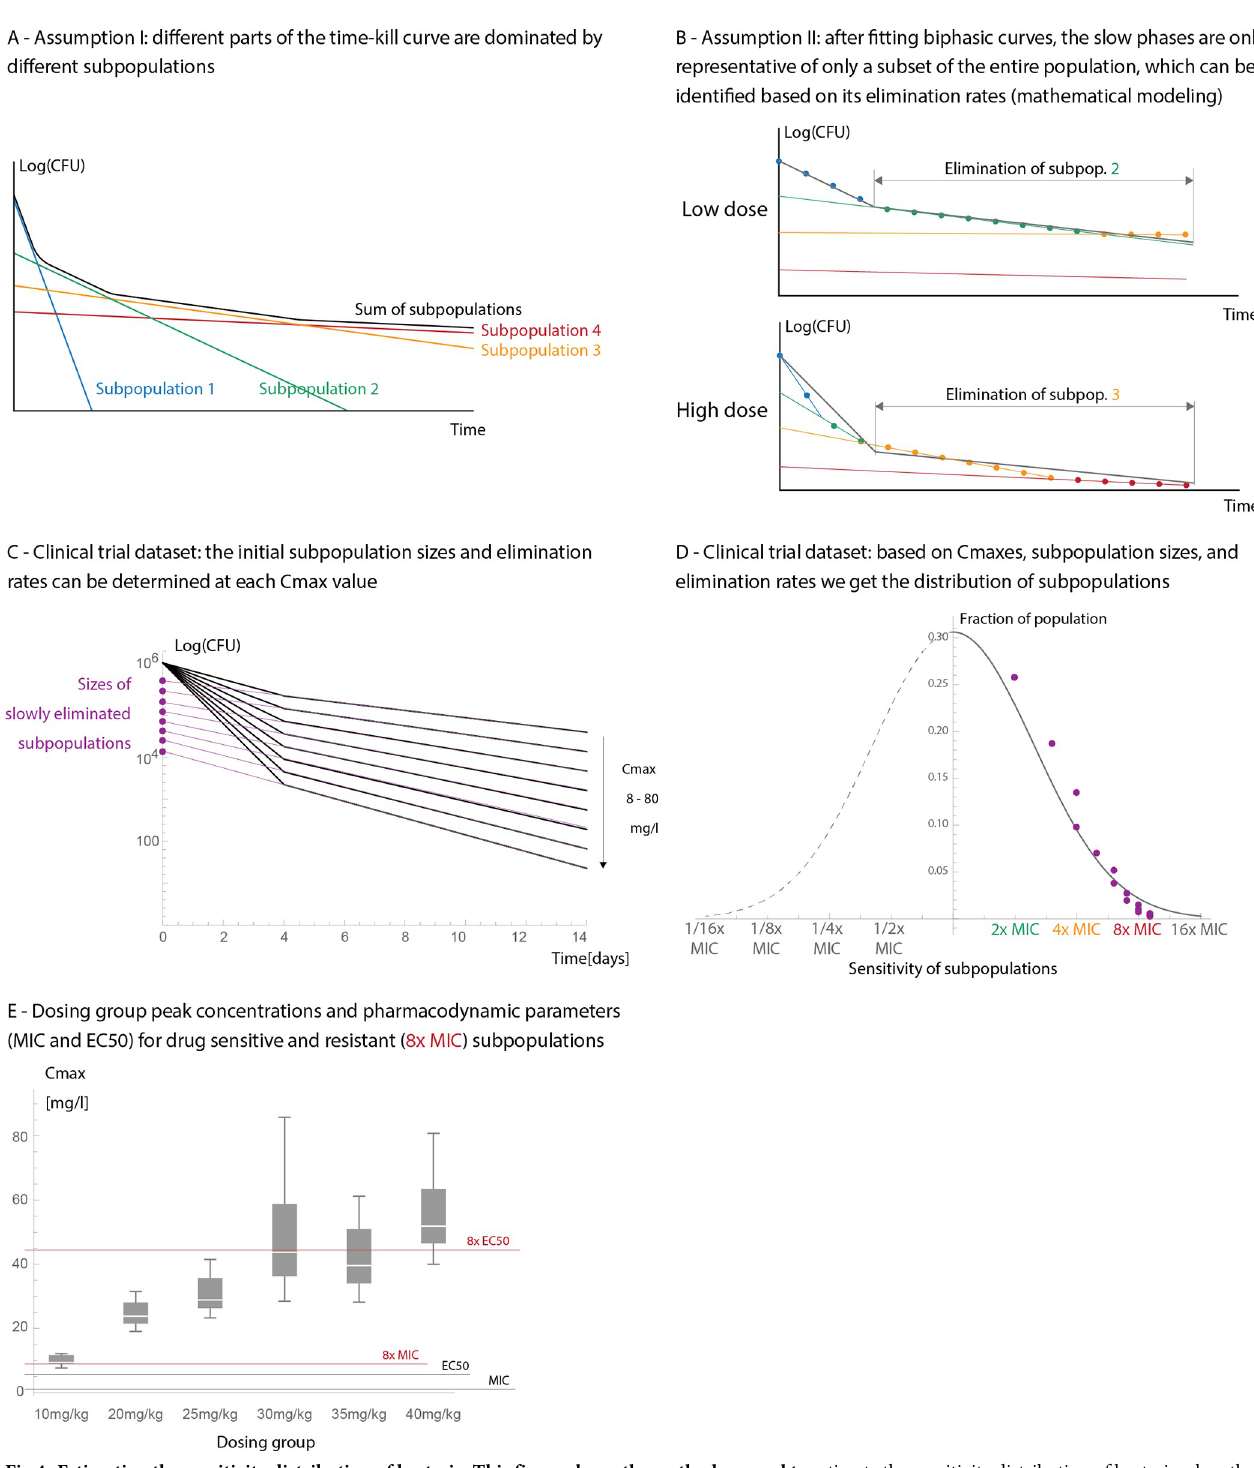
PLOS Computational Biology | https://doi.org/10.1371/journal.pcbi.1011000 April 13,